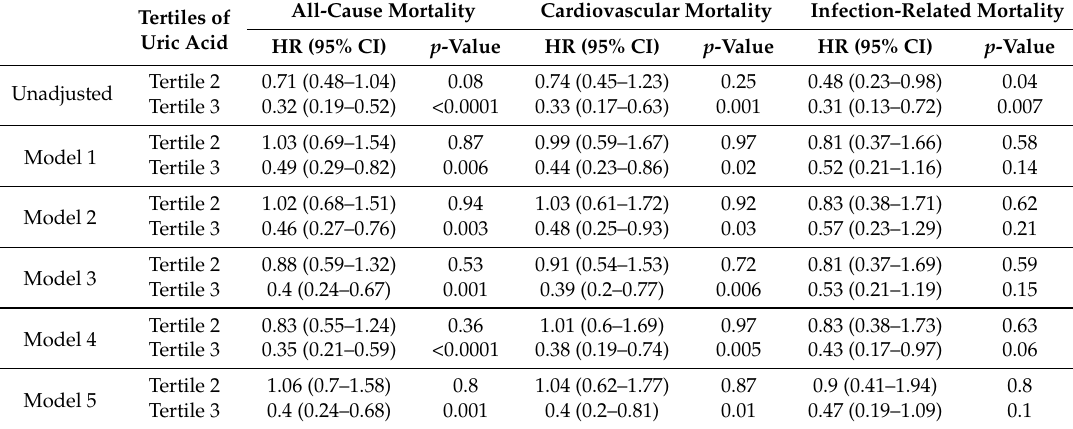
Figure 1. Crude analysis of all-cause mortality rate between the sex-specific tertiles of serum uric acid levels ( p < 0.001). Table 2. Cox regression models of all-cause, cardiovascular and infection associated mortality for uric acid (sex-specific tertiles).